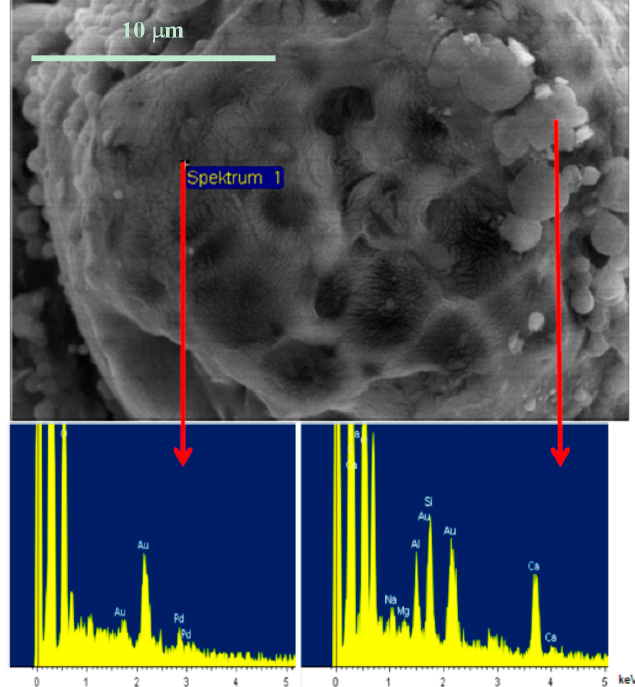
Figure 3. Top: SEM photo of a burst (due to high temperatures during sample preparation) PLA/MMT hybrid latex particle. Bottom left : EDX spectrum of the PLA region. Bottom right : EDX spectrum of the MMT region, which is only located at the original surface of the spherule.